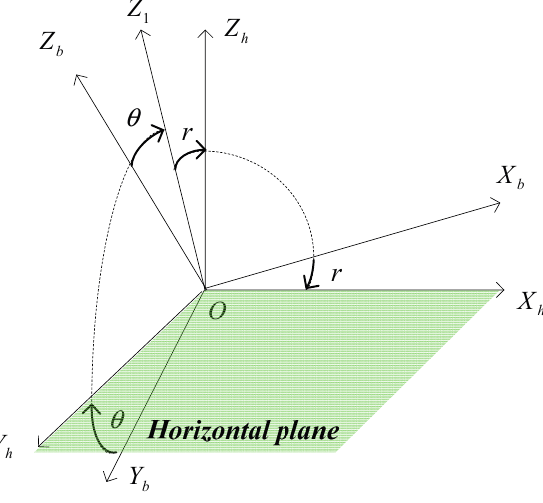
Figure 3. Transformation from the b-frame to the